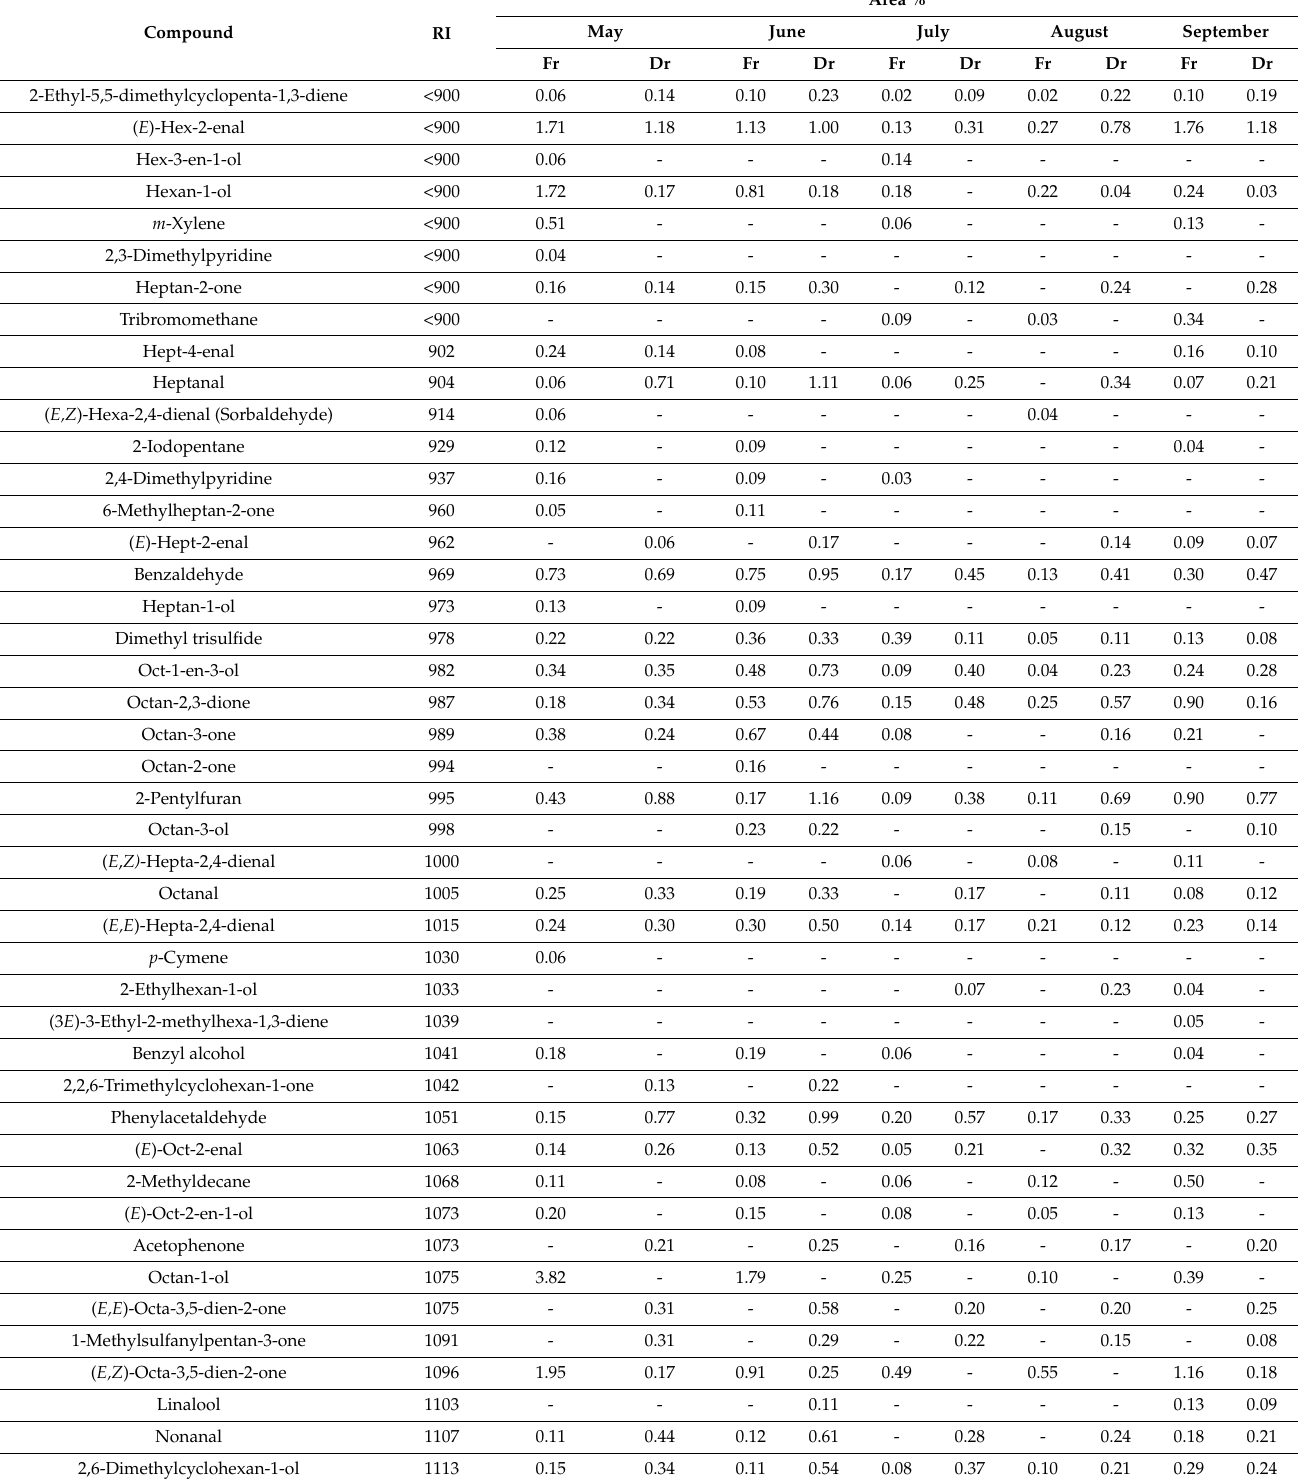
Table 3. The volatile compounds from H. scoparia acquired by hydrodistillation (HD) and